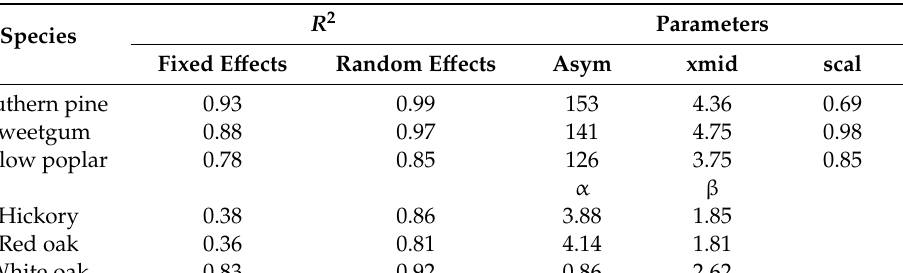
Table 2. Model parameters and fit statistics for the six species.